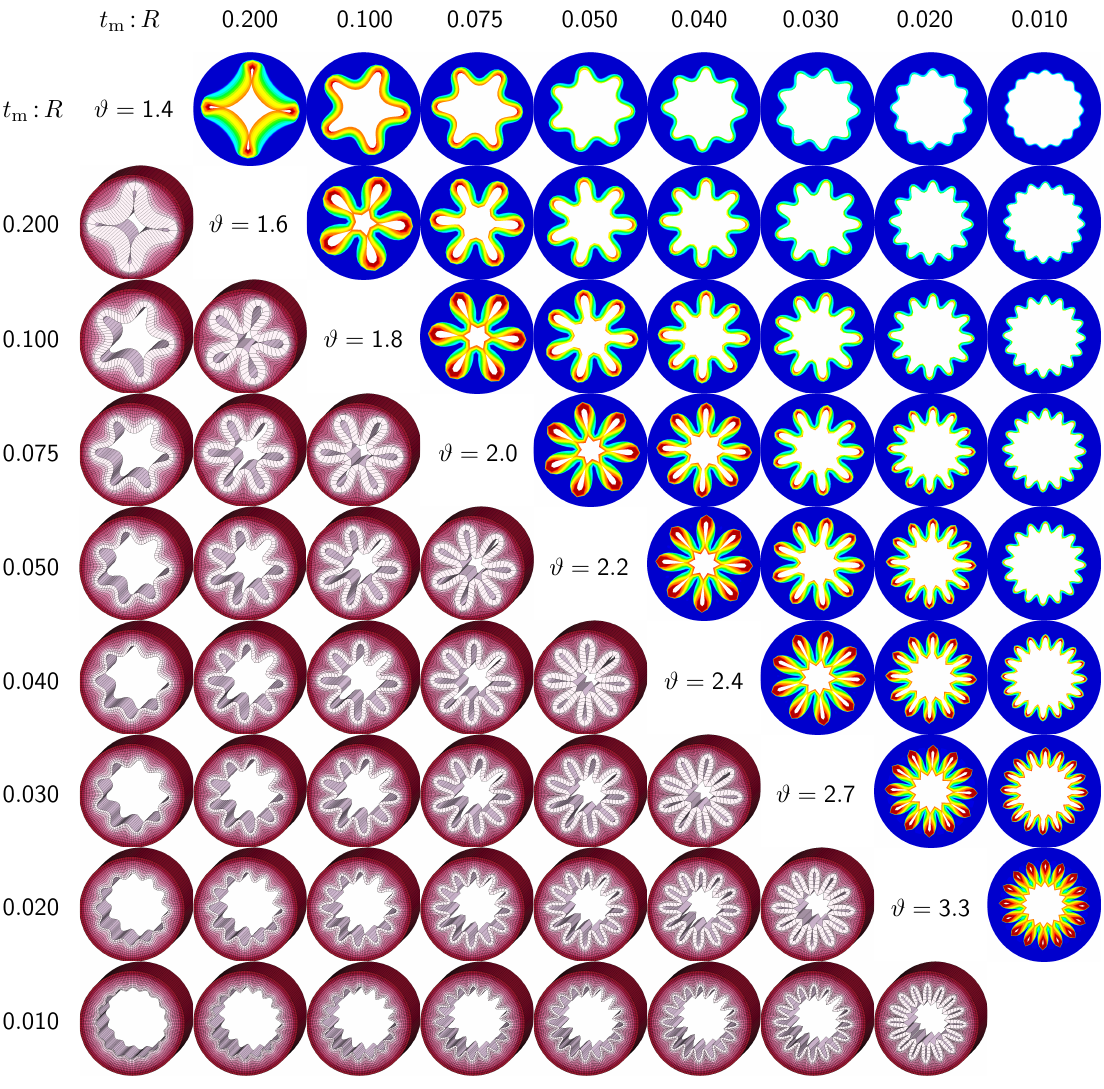
Figure 6. Sensitivity of failure mode with respect to relative mucosal thickness for a : R = 1 . 0 . Larger relative mucosal thicknesses represents circular cross-section with R I II smaller bronchi away from the trachea; smaller relative mucosal thicknesses represents larger bronchi close to the trachea. With increasing relative mucosal thickness, the number of folds decreases. With the decreasing number of folds, the critical growth ϑ at the first contact becomes significantly smaller. This might indicate that smaller bronchi with a larger relative mucosal thickness are at a higher risk of airflow obstruction than larger bronchi with a smaller relative mucosal